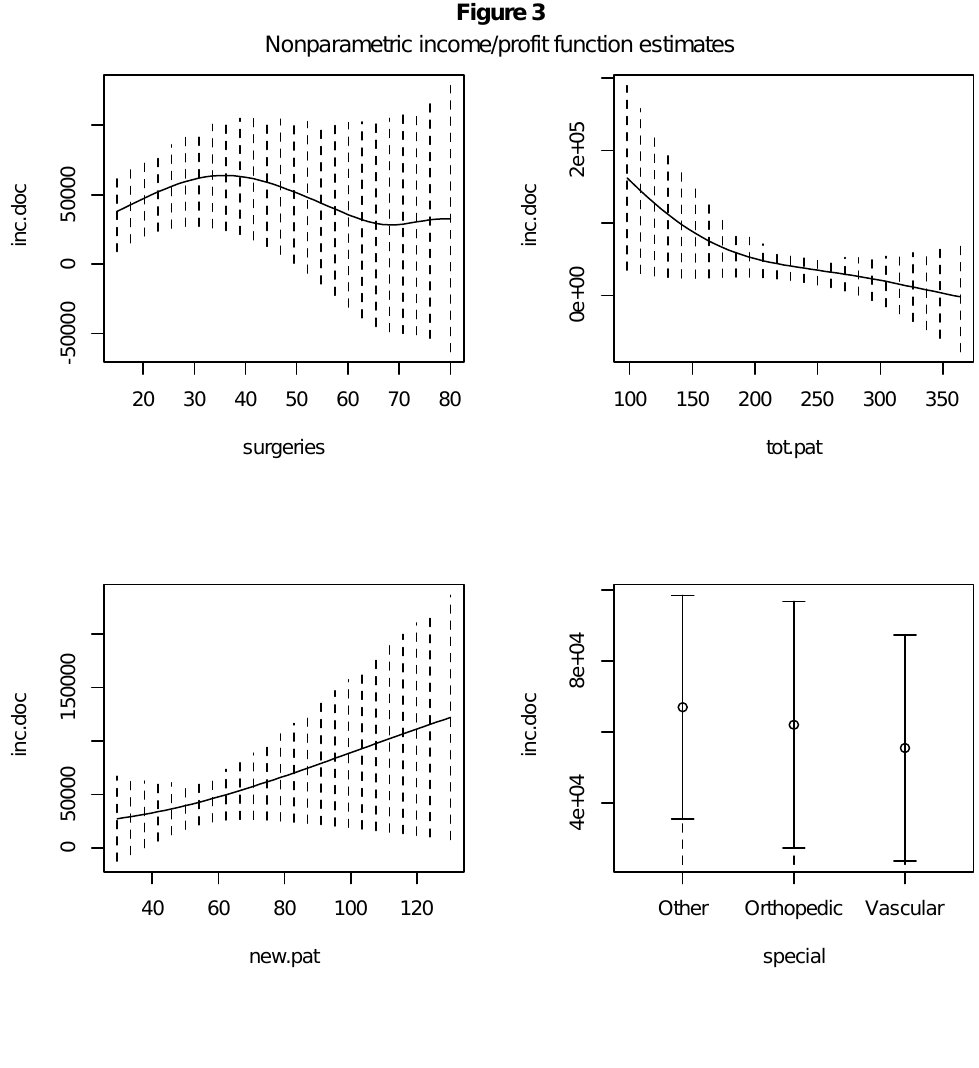
Nonparametric income/profit function